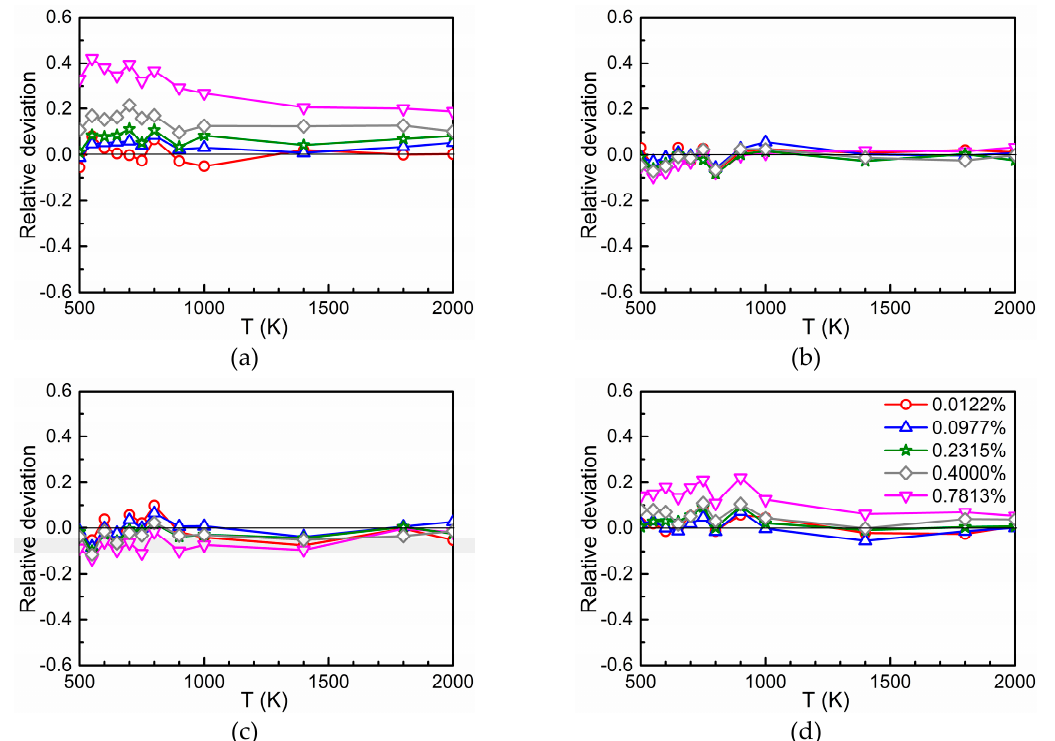
c in the )] / D ( c 0 ) for di ff erent values of c S in the case of inter S S S = 0.0015%). If the interaction region between c = 0.0015%). If the interaction region S S